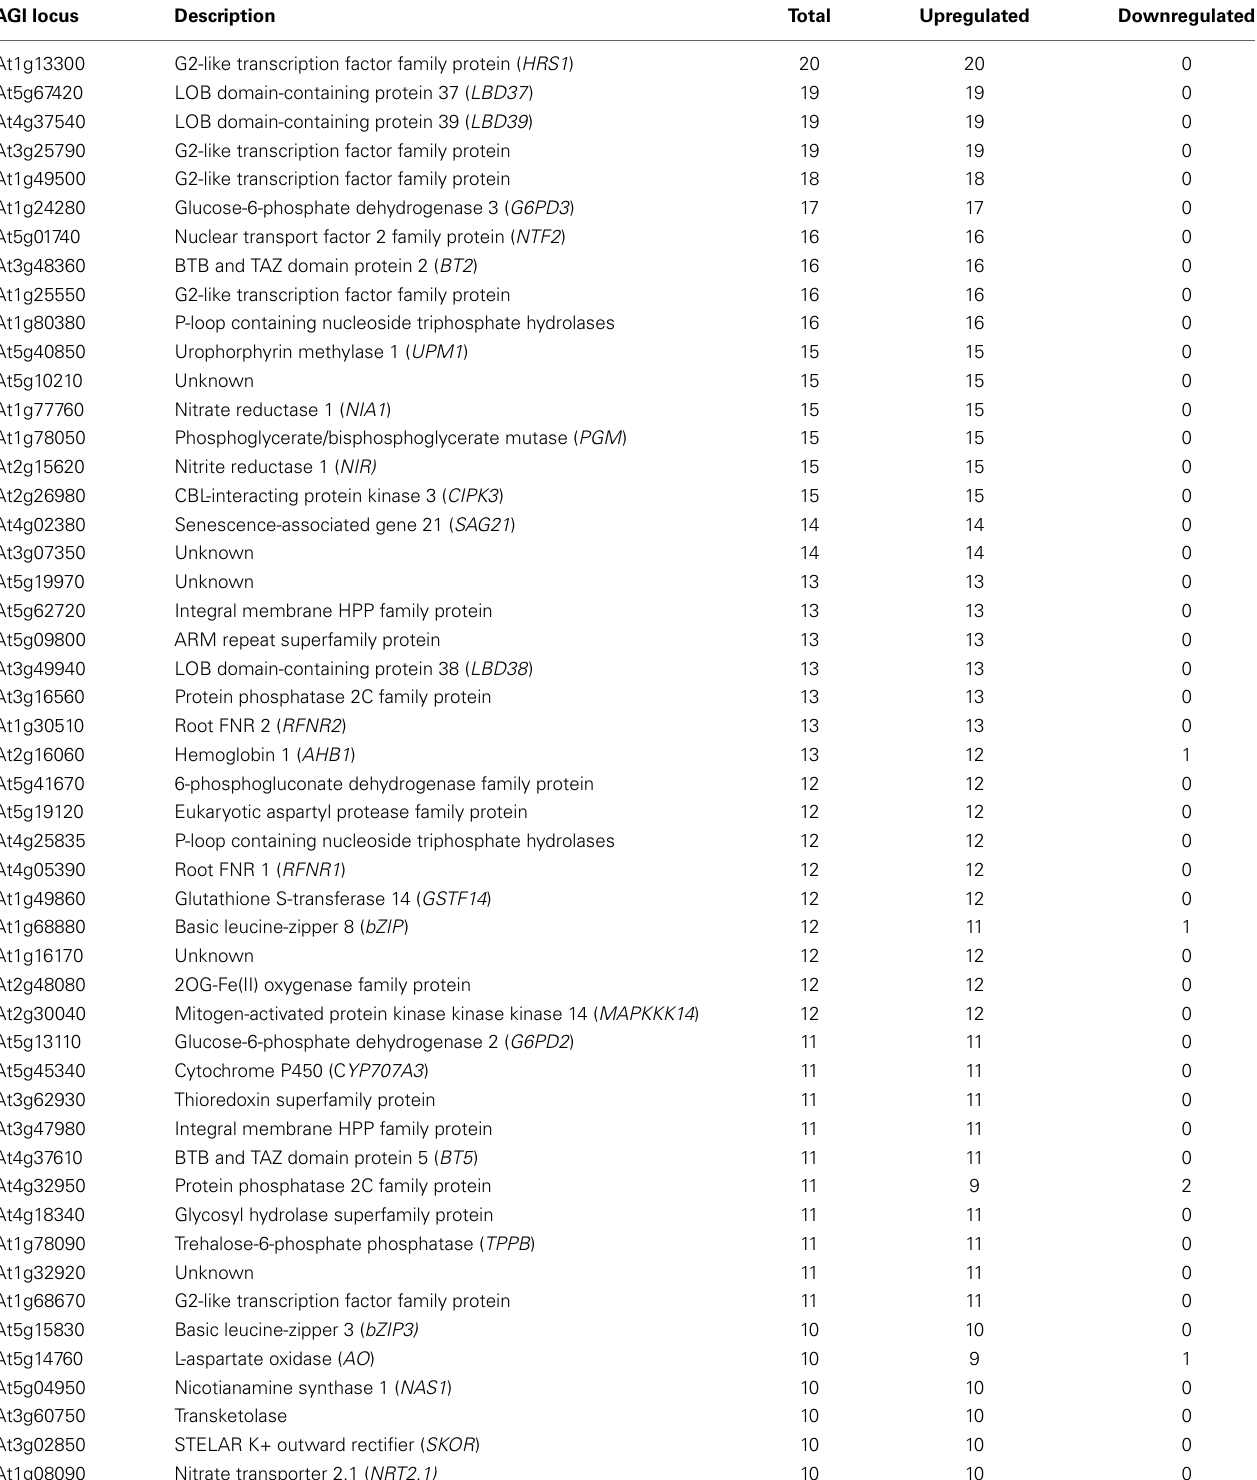
Table 2 | Ranking of the top 50 most consistent genes in response to nitrate. AGI